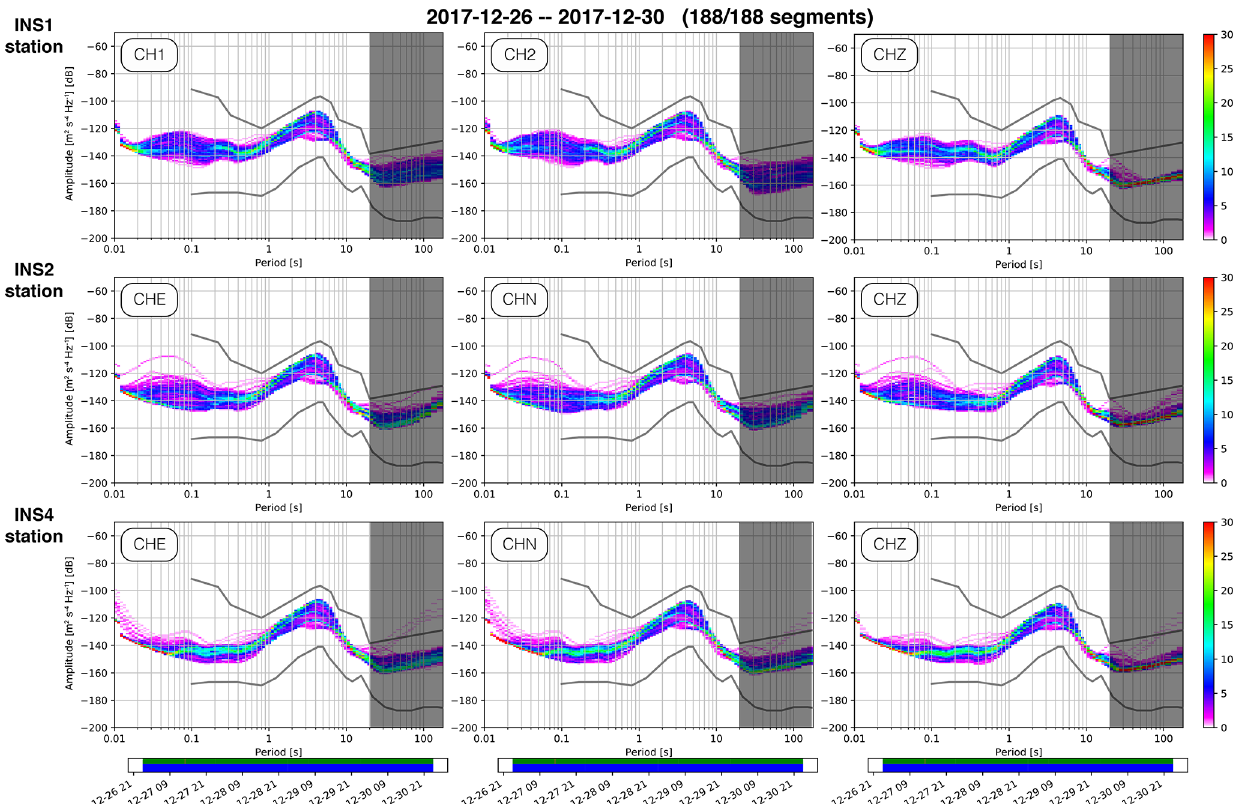
Figure 8. Same type of comparison as Fig. 7 but among stations INS1 (sensor installed at 50m depth), INS2 and INS4 (respective sensors both installed at 6m